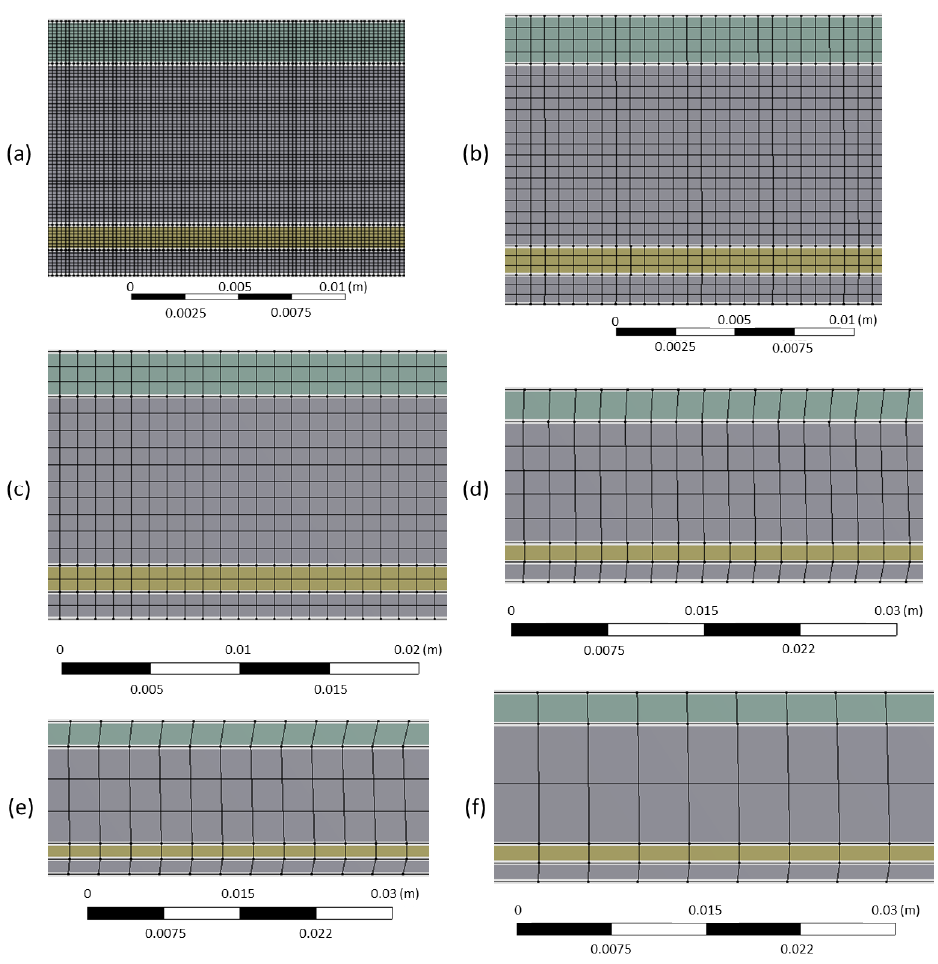
Figure 3. Quadrilateral meshing sizes for the study of independency on meshing: ( a ) mesh size = 0.2 mm; ( b ) mesh size = 0.6 mm; ( c ) mesh size = 1 mm; ( d ) mesh size = 2 mm; ( e ) mesh size = 3 mm; ( f ) mesh size = 4 mm.